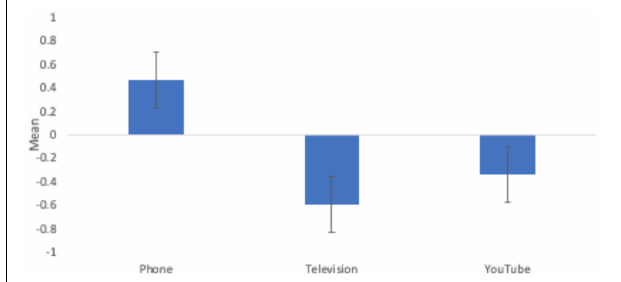
FIGURE 2 | Children’s reality status judgments by medium.